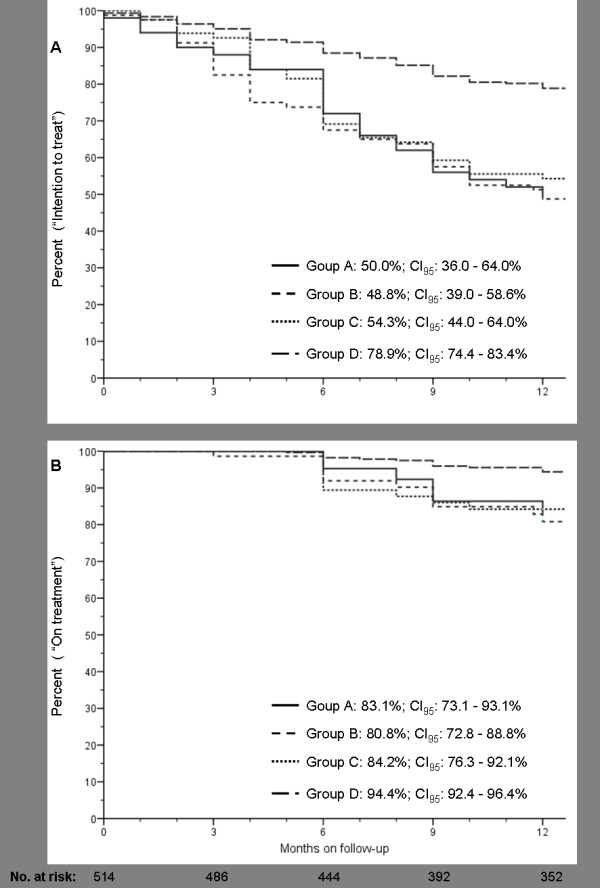
A) Kaplan-Meier estimates of the percentage of patients without treatment failure (intention-to-treat) and B) without virological failure (on treatment) through week 52. Groups A: antiretroviral-naïve patients, B: patients who restarted ART after a temporary dropping out or lost to follow-up, C: patients with virological failure to a preceding PI- or NNRTI-based regimen, and D: those with an undetectable viral load who simplified a PI-based regimen or had toxicity to a previous regimen based on PIs or NNRTIs.